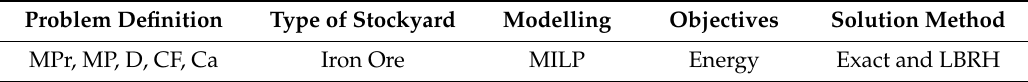
Table 3. Coding this paper (see Nomenclature in Table 1).